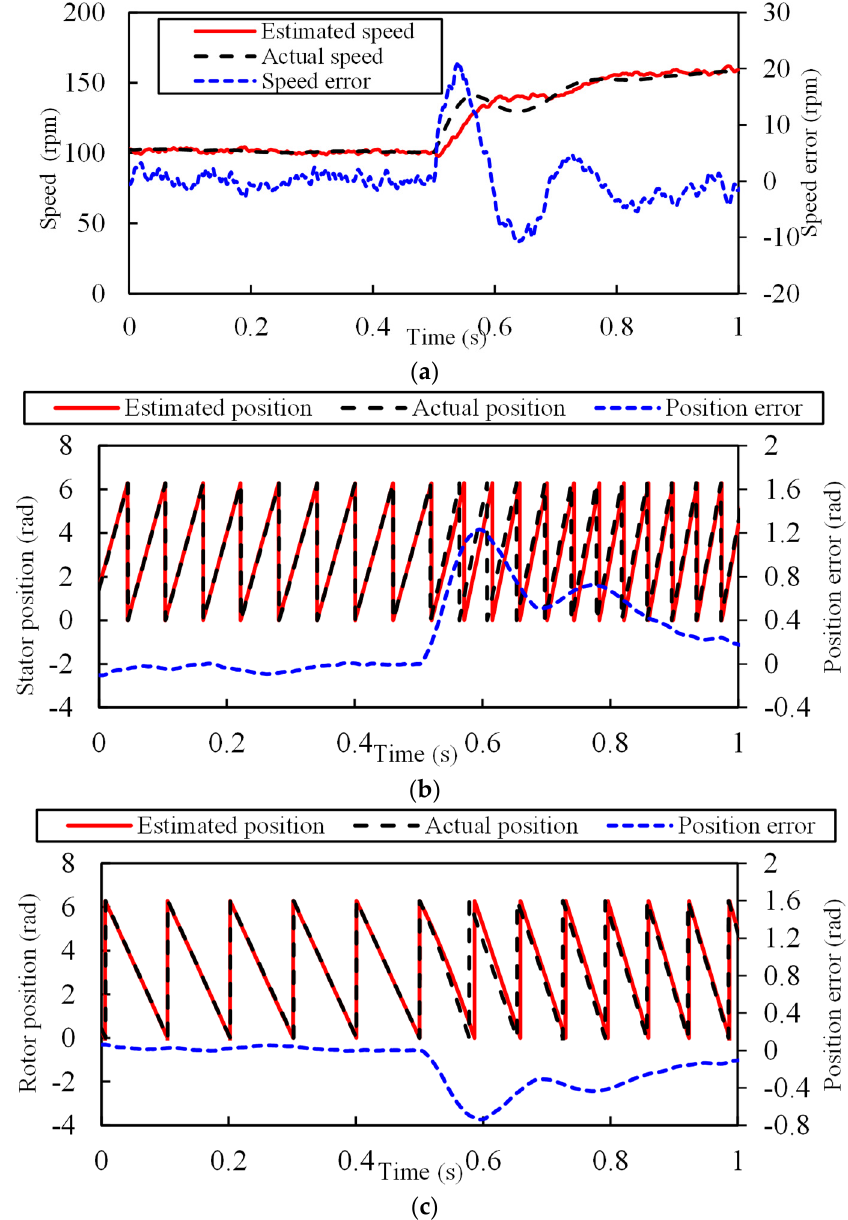
Figure 13. The speed step results of estimating from the same side. ( a ) Speed. ( b ) Stator position. ( c ) Rotor position.